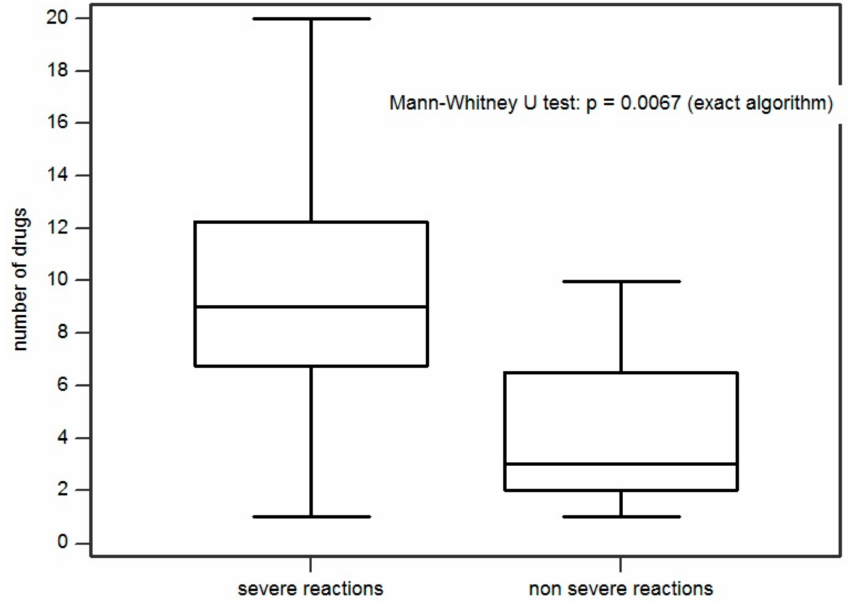
Figure 2. Association between reaction severity and number of medication in home